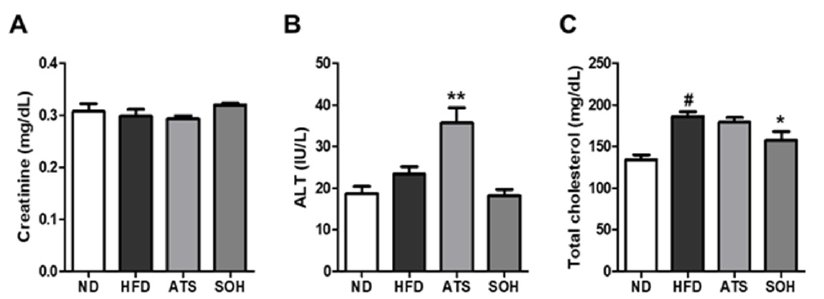
Figure 5. Blood analysis. Blood analysis was performed after killing the mice after 8 weeks. ( A ) Creatinine, ( B ) alanine aminotransferase (ALT), and ( C ) total cholesterol. ND: normal food control, HFD: HFD control; ATS: HFD + atorvastatin 30 mg/kg oral administration; SOH: HFD + SOH 20 mg/kg (hispidulin, synephrine, p -octopamine HCl in a 1:1:1 mixture) oral administration. Data are shown as means ± SEM. A one-way ANOVA and Bonferroni post-hoc analysis were used to com- pare normal and HFD ( # p < 0.05) and HFD with each group ( * p < 0.05, ** p < 0.001).